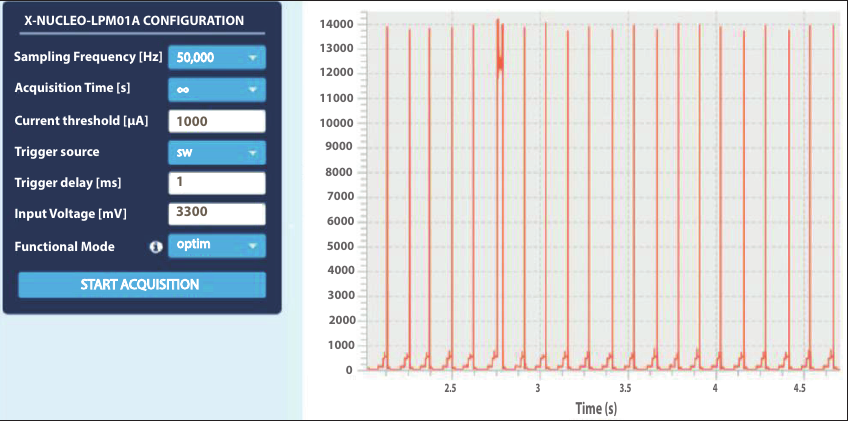
Figure 9. Electrical power consumption of STM32L152RE in sleep mode under 65